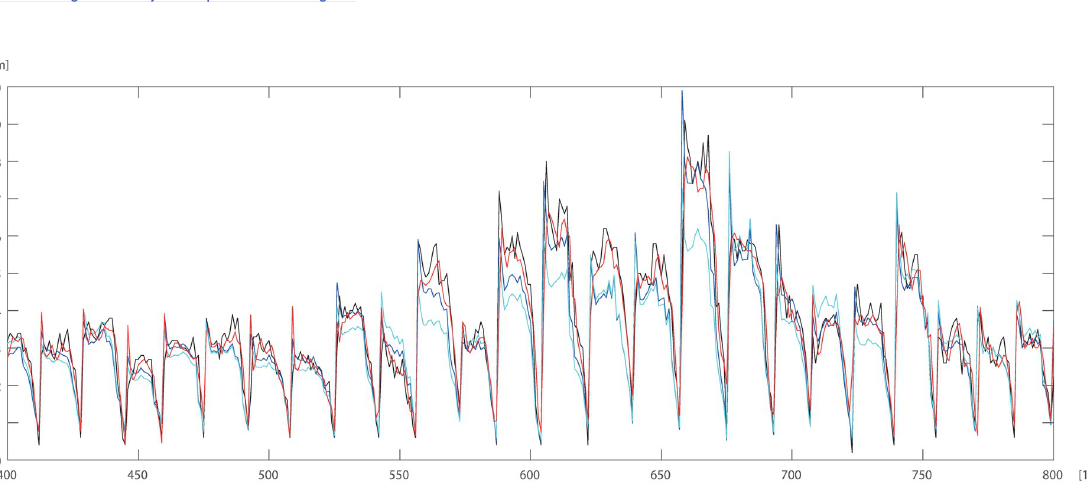
Fig 5. 150 DBT data (black line), STAT 2 (blue line), STAT 1 (cyan line), ANN (red line) for pine. Horizontal axis [1]—identifier of measurement.